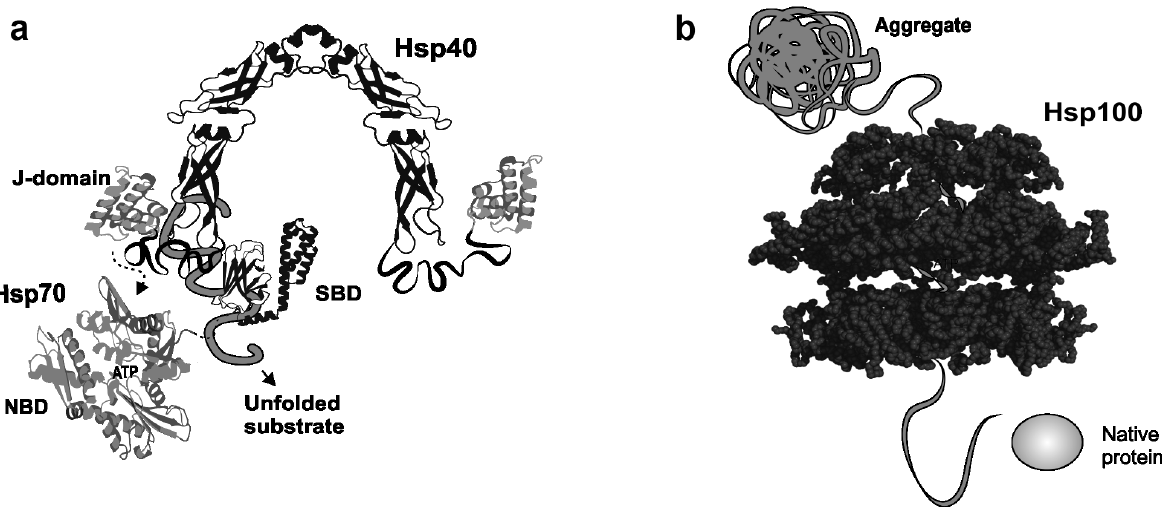
Figure 1 - Molecular chaperones and heat shock proteins can be classified by their interaction with substrates. a) Holders bind client proteins in an ATP-independent manner, named this way because they secure the client protein for further action by other chaperones, commonly a foldase, that coaxes the substrate into its native state in an ATP-dependent manner. In this figure, the holder is represented by an Hsp40 (PDB accession number 1C3G) that delivers a client protein (unfolded substrate) to the NBD of Hsp70 (PDB accession number 1HJO) (modified from Borges et al. 2012); SBD: substrate binding domain from Hsp70. b) Disaggregases have the remarkable ability to extricate protein monomers from aggregates in an ATP-dependent